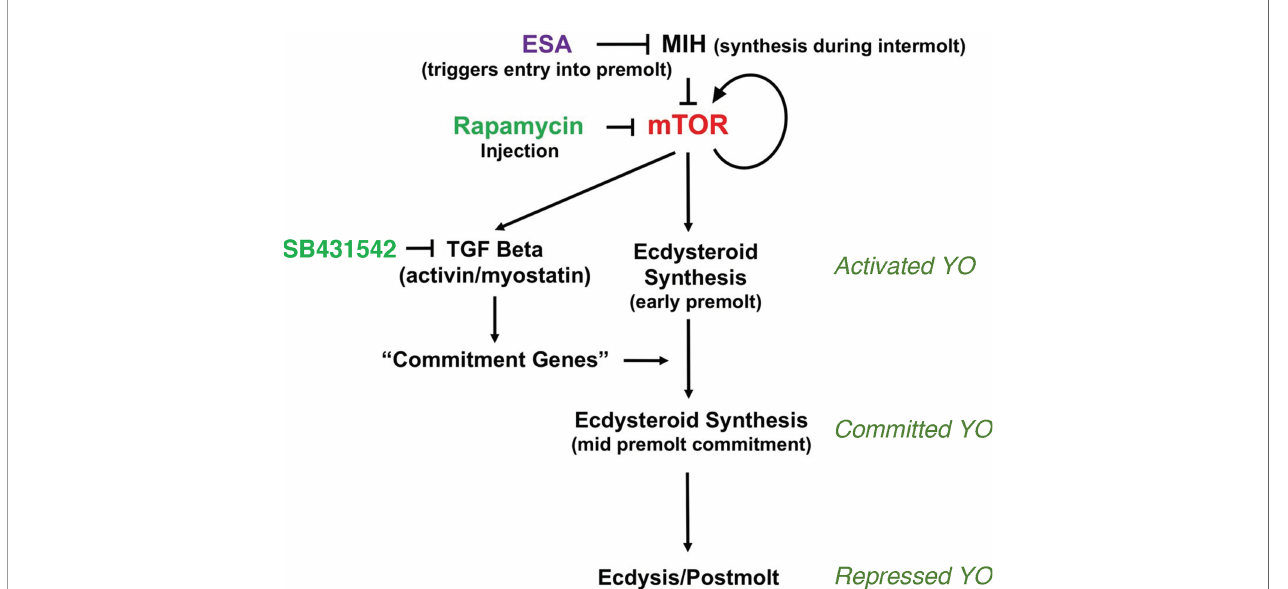
FIGURE 1 | Organization of the signaling pathways mediating YO phenotype transitions over the molt cycle. Cyclic nucleotide-mediated MIH signaling maintains the YO in the basal state by inhibiting mTOR signaling. Reduction in MIH, such as by eyestalk ablation (ESA), stimulates mTOR activity, which is inhibited by rapamycin. mTOR stimulates ecdysteroid synthesis and up-regulates mTOR and TGF b /Activin signaling genes, and down-regulates MIH signaling genes. Activin/myostatin signaling, which is inhibited by SB431542, up-regulates mTOR signaling genes and controls expression of commitment genes that determine the committed phenotype. High ecdysteroid titers in late premolt may trigger the repressed phenotype in postmolt. From